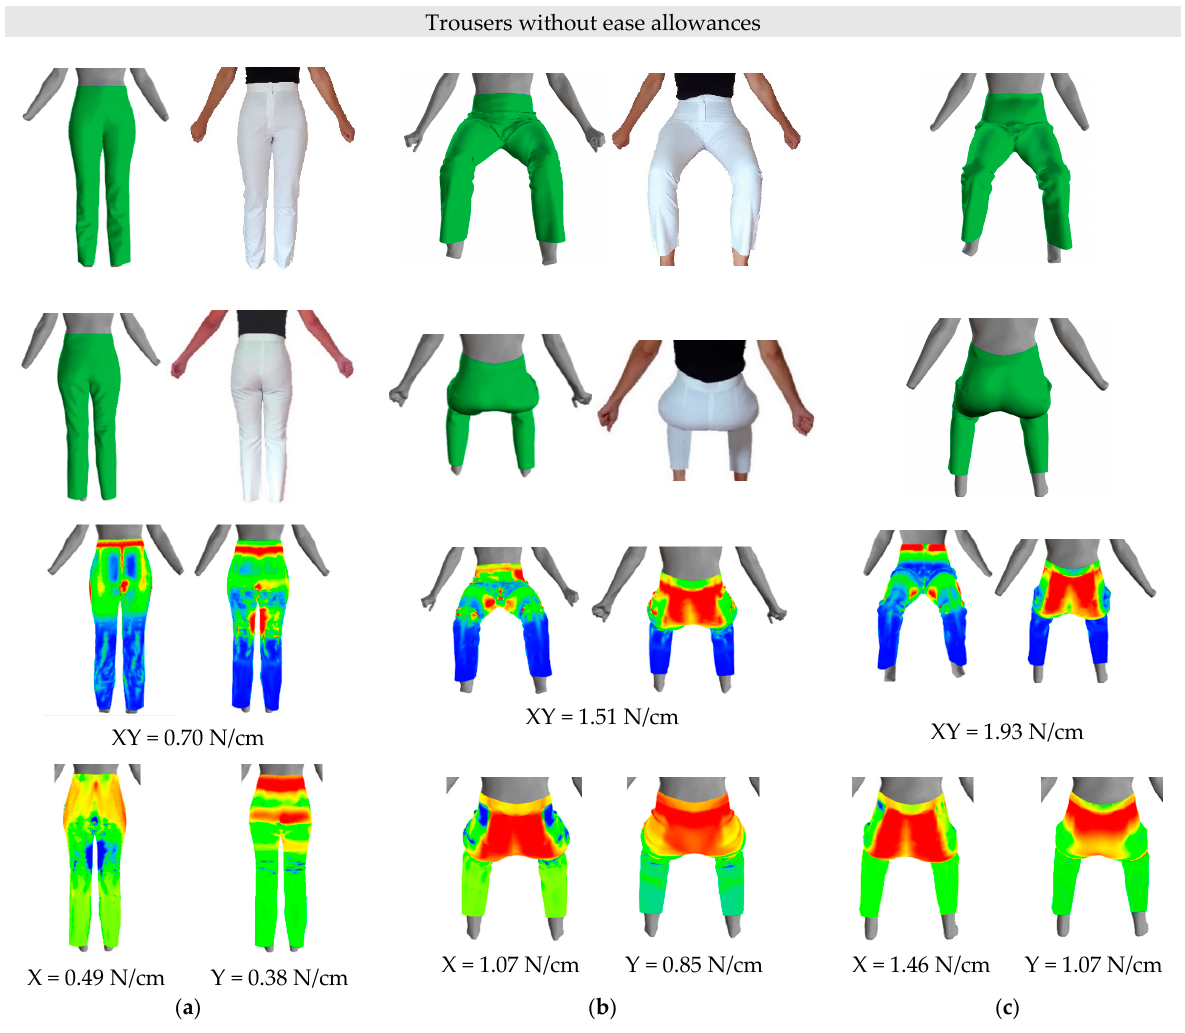
Figure 9. Virtual and real-trouser prototypes without ease allowances and tension in trouser fabric: ( a ) standing 3D body model and real person, ( b ) sitting 3D body model and real person, ( c ) kinematic sitting 3D body model.